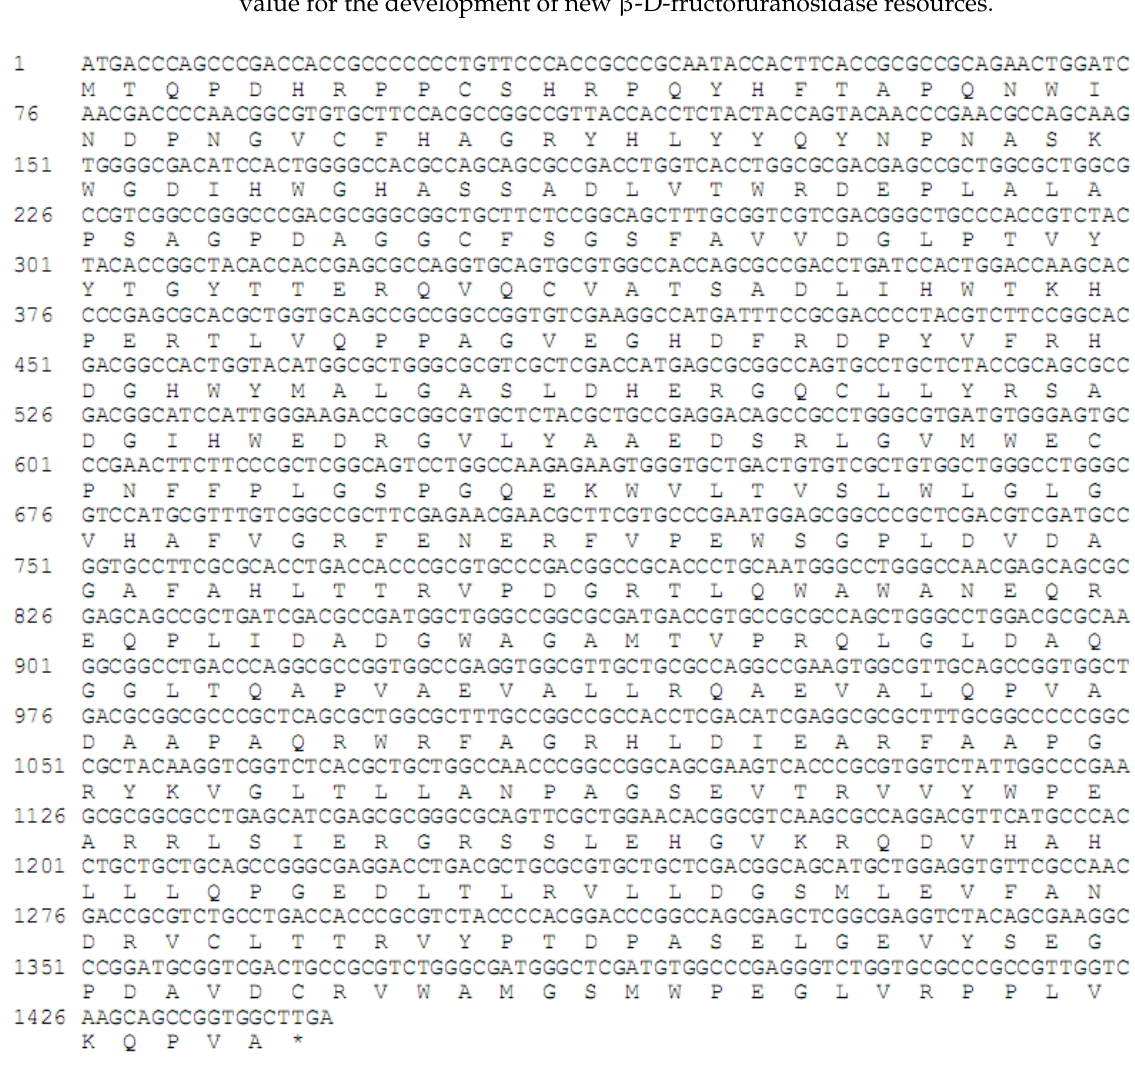
Figure 1. Nucleotide and deduced amino acid sequences of the full-length cDNAs and fl anking regions of LcFFase1s.